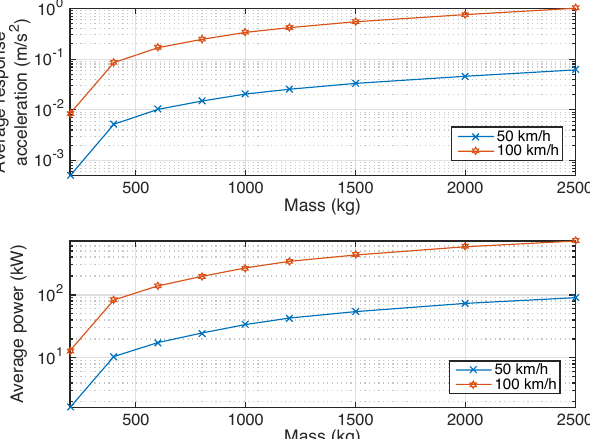
Figure 13. Average response acceleration and average recoverable power from one electromagnetic suspension on a wheel with varying mass on top of one